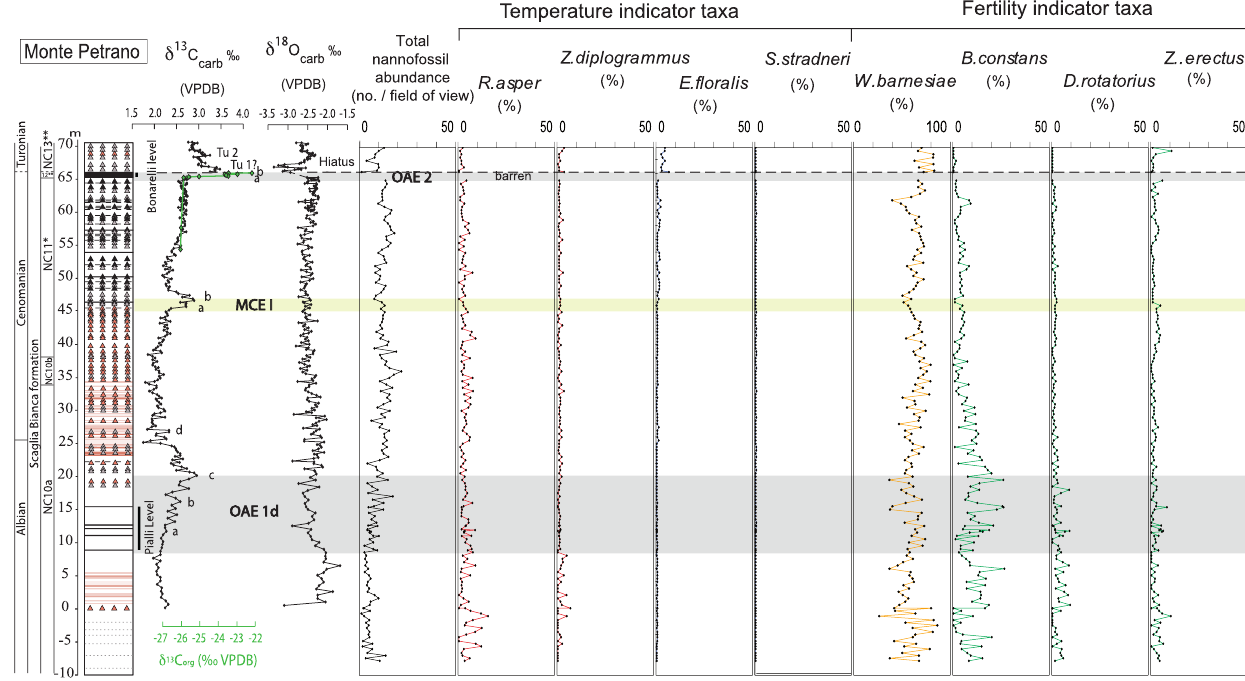
Figure 2. Monte Petrano: total calcareous nannofossil abundance (average number of specimens in one field of view), relative abundance (%) of temperature and fertility indicator nannofossil species. The OAE 1d and OAE 2 are indicated by a grey band, the MCE I is represented by a yellow band. The stratigraphic framework (lithostratigraphy, biostratigraphy, chemostratigraphy) is from Gambacorta et al. (2015).